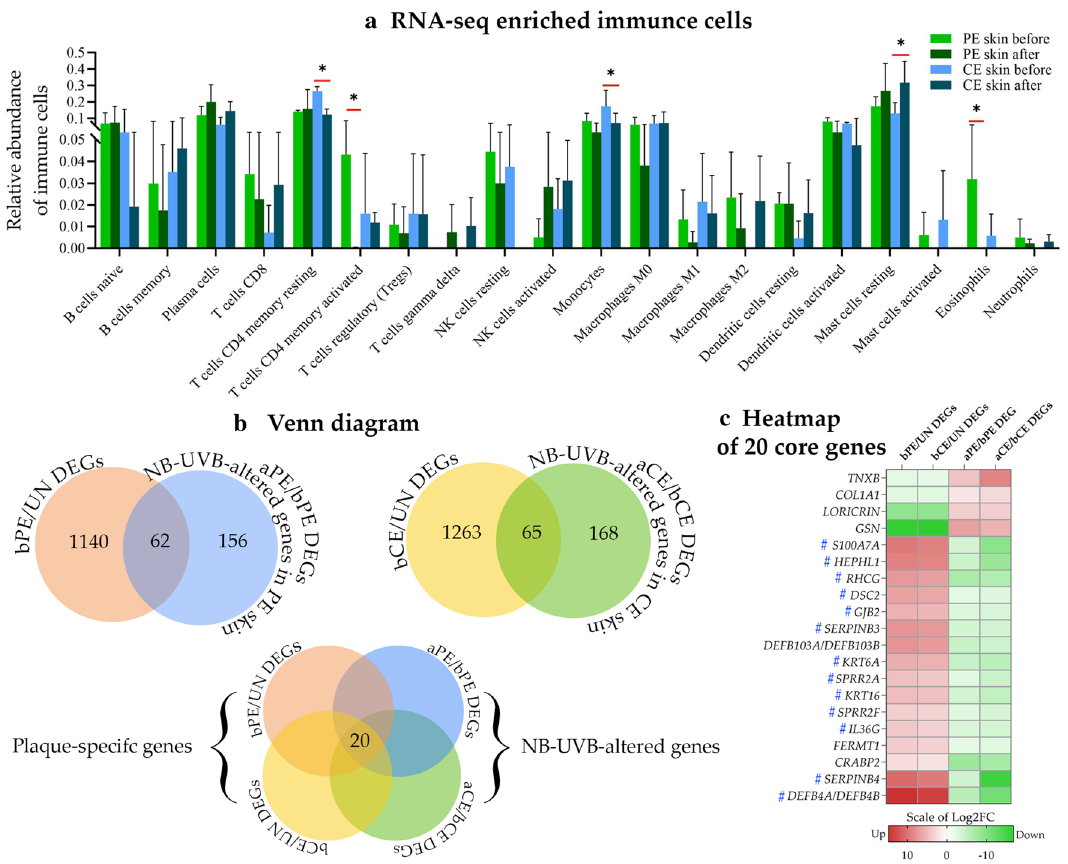
Figure 1. RNA-seq visualization. ( a ) Relative abundance of immune cells comparing before and after NB-UVB treatment in the PE skin and CE skin. Immune cell deconvolution was performed using the LM22 gene signature matrix and CIBERSORTx algorithm. The graph shows the mean and standard deviation of relative abundance. Significance was analyzed using the LIMMA package in Bioconductor. * p < 0.05. ( b ) Venn diagram showing the intersection implicating the number of altered plaque-specific genes. (c) A heatmap showing 20 NB-UVB-altered core genes. # , indicates the psoriasis signature genes. aCE skin After-treatment CE skin, aPE skin After-treatment PE skin, bCE skin Before-treatment CE skin, bPE skin Before-treatment PE skin, DEGs Differentially expressed genes, FC Fold change, NB‑UVB Narrow band ultra violet B, UN skin Uninvolved